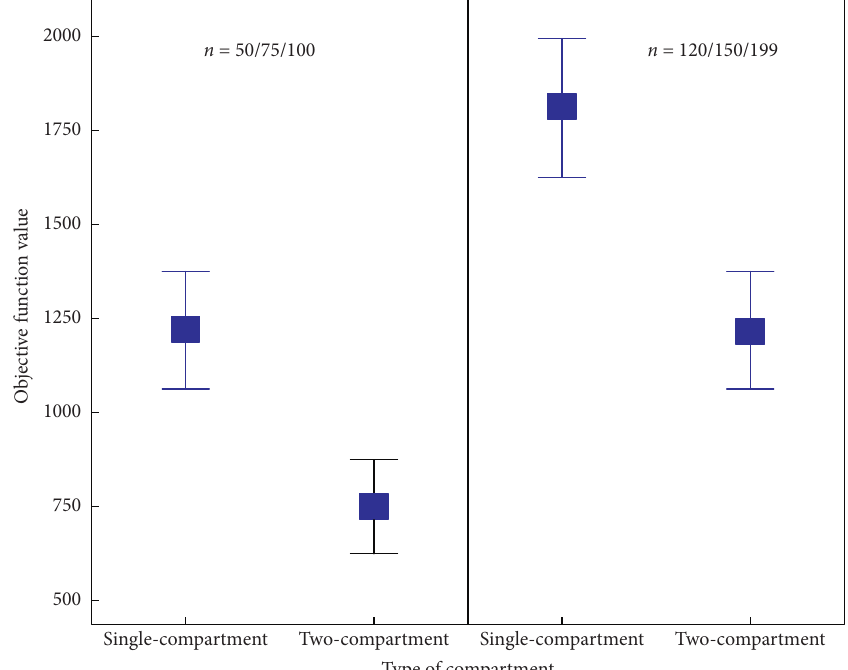
Figure 3: Comparison results of vehicles with different